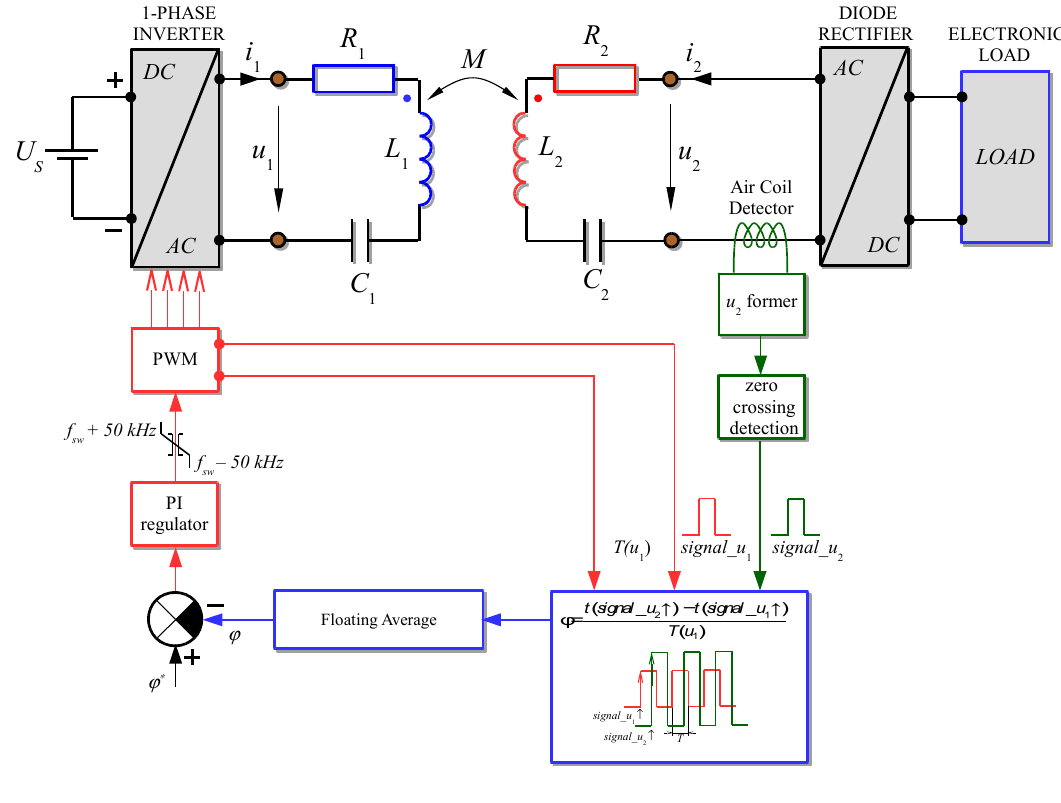
Figure 4. Block diagram of the proposed tracking algorithm.